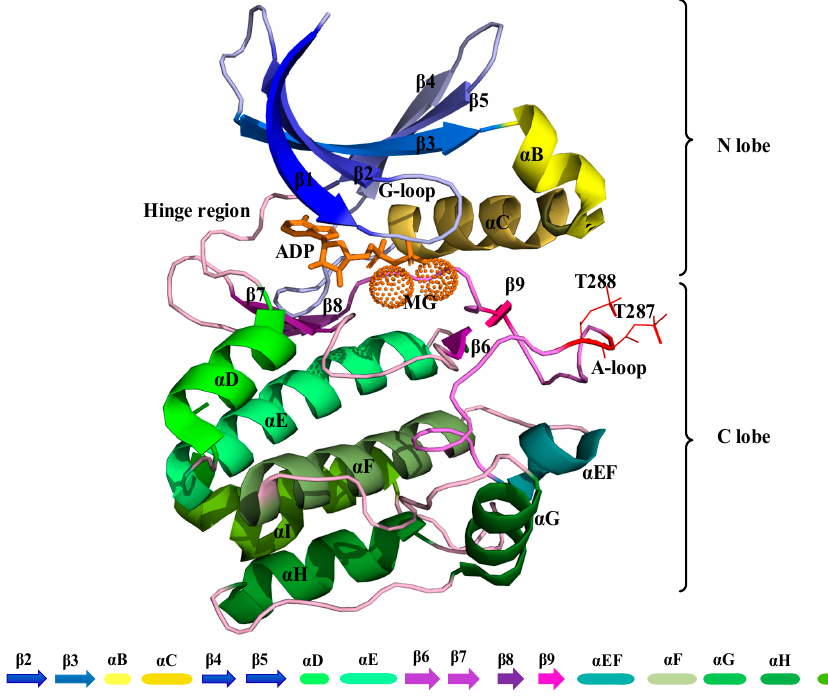
Figure 1. Cartoon representation of the kinase domain of Aurora-A (PDB 1OL7). The A-loop is colored light purple (residues 274–299) with the phosphorylated threonine residues at positions 287 and 288 shown as a line in red color. ADP is colored orange with coordinated Magnesium ions shown as light orange pointed spheres. Aurora-A has conserved sequence and structural features that are organized into an “open” conformational arrangement, whenever the kinase is in an active state. In contrast, such features are displaced and unorganized in a “closed” state, when the kinase is inactive (Figure 2). The A-loop and the control of its conformation, with ligands and post-translational phosphorylation, play a key role in modulating the activity of Aurora-A. Active/open forms of Aurora-A are phosphorylated on Thr-287 and Thr-288 of the A-loop (Figure 1). The phosphorylation of Thr-288 is known to activate the kinase, but the function of Thr-287 phosphorylation remains unclear [6,7]. In its unphosphorylated form, Aurora-A has been captured in an inactive/closed conformation in which the C-helix and the A- loop are sometimes disordered and/or rearranged (Figure 2). Therefore, the fundamental differences between the active/inactive states of Aurora-A are essentially determined by inter-lobe motions, the position of the C-helix, which is twisted outward from the N-lobe in the closed state, and the A-loop that is displaced onto the C-terminal lobe, as shown in Figure